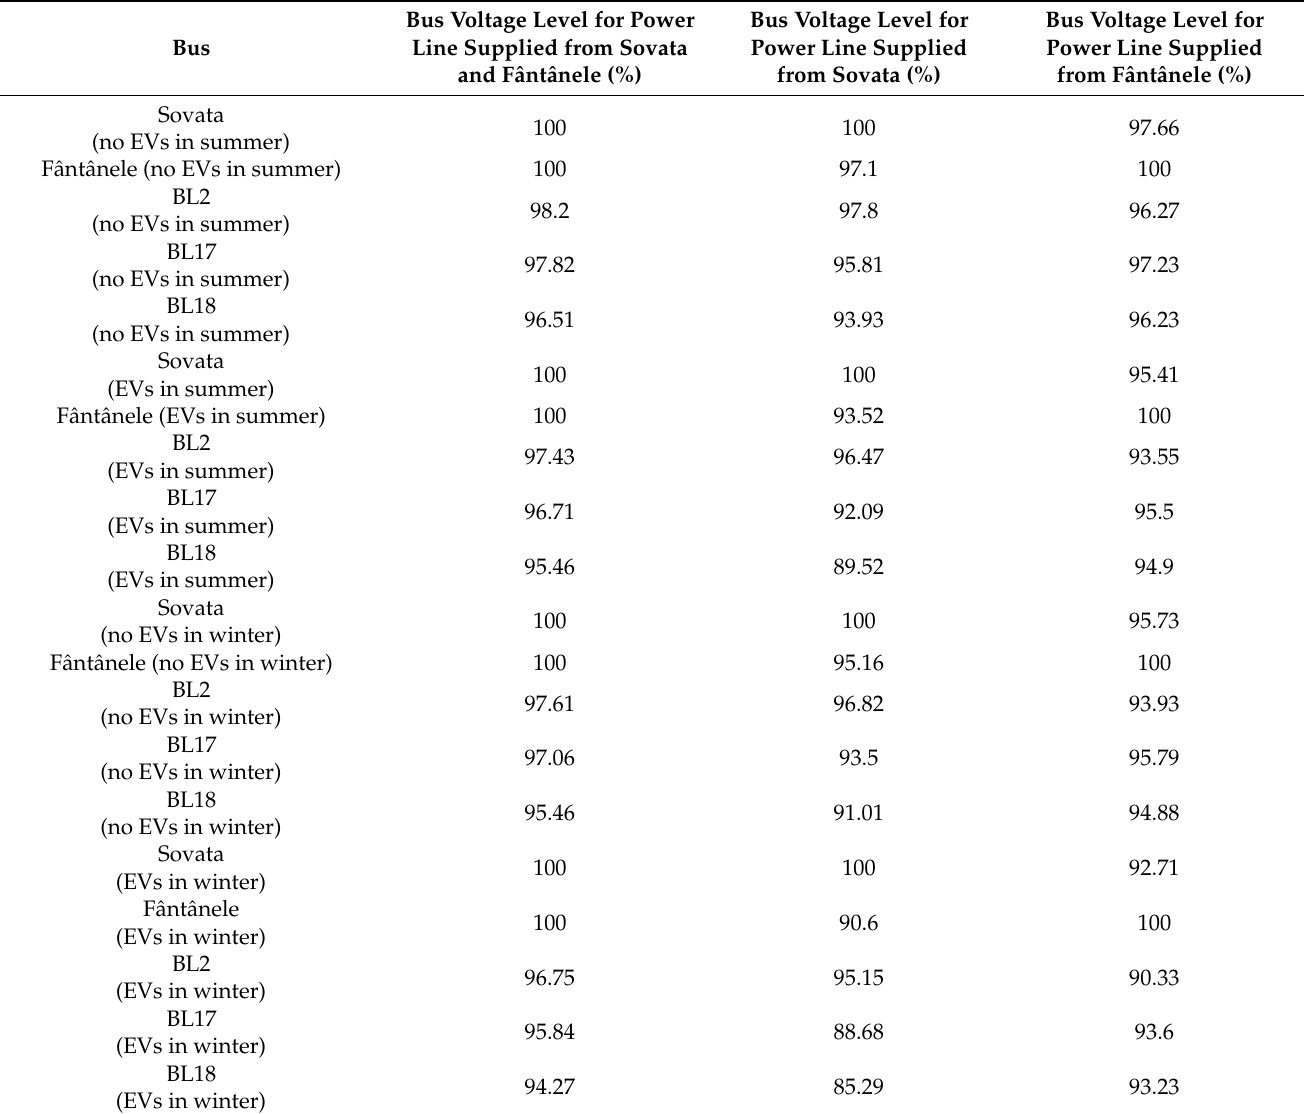
Table 30. Voltage level at 18:00 (scenario